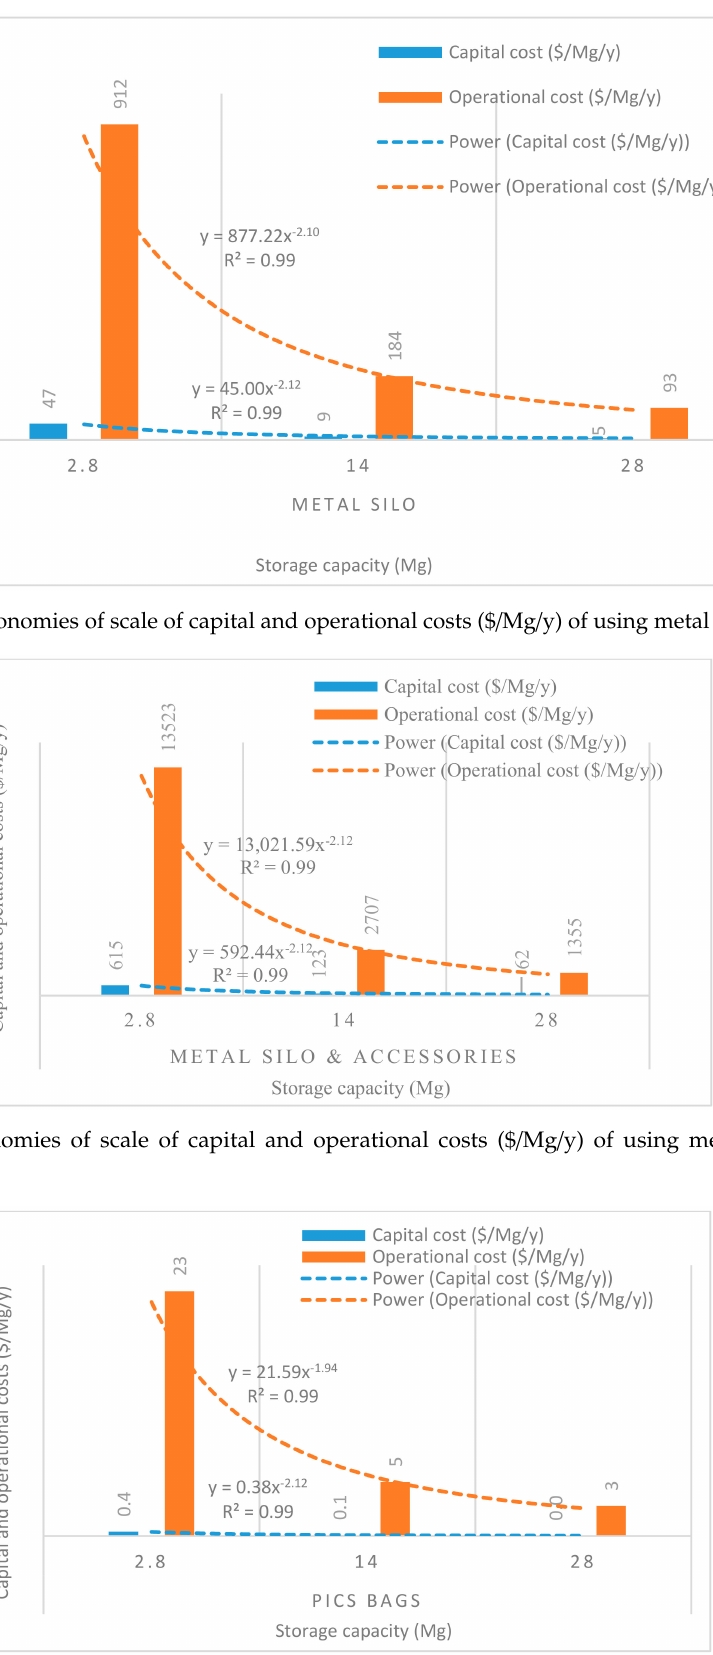
Figure 10. Economies of scale of capital and operational costs ($ / Mg / y) of using PICS bags